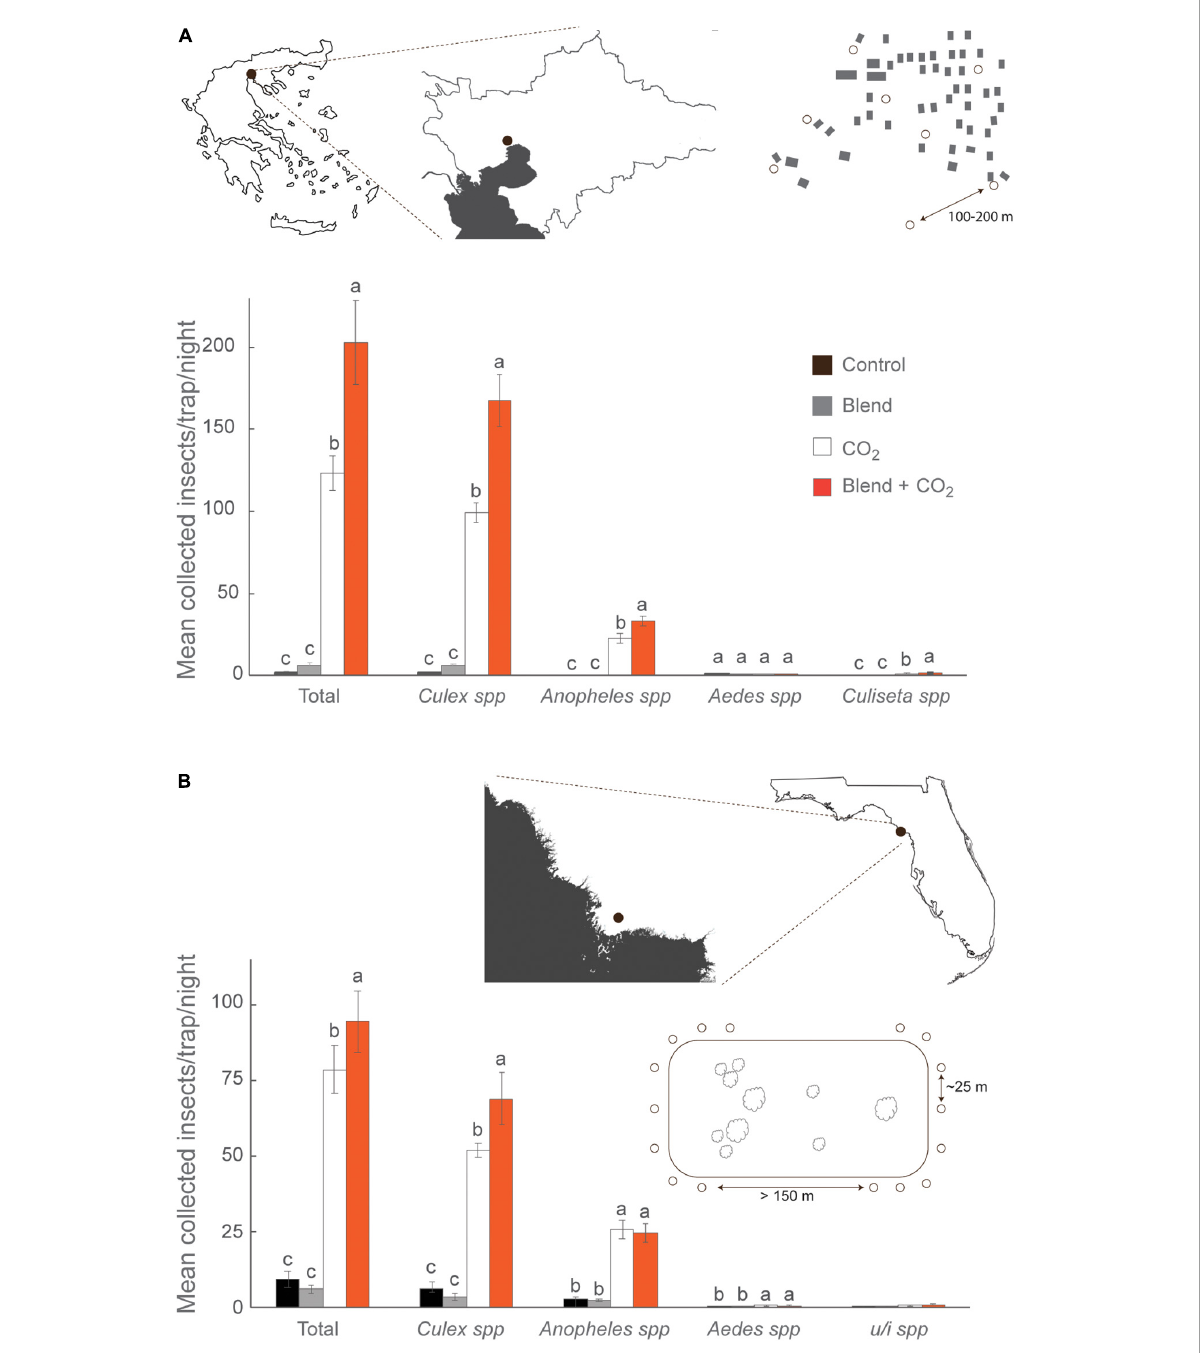
FIGURE3 Field assessment of the synthetic chicken odor. Deployment of traps ( ◦ ) in (A) Sindos, Thessaloniki (Greece) and (B) Cedar Key Scrub State Reserve (FL, United States). At both sites, the synthetic chicken odor blend, when combined with carbon dioxide (CO 2 ), significantly enhanced the abundance and diversity of mosquito species that include birds in their diet, when compared to CO 2 -baited and control traps, when analyzed using a mixed effects model. In the absence of CO 2 , traps baited with the synthetic chicken odor blend caught similar number of mosquitoes as the control traps, as shown using a pairwise comparison t -test. Lowercase letters indicate significant differences by P < 0.05. Error bars denote standard error of the mean ( A: N = 16; B: N =